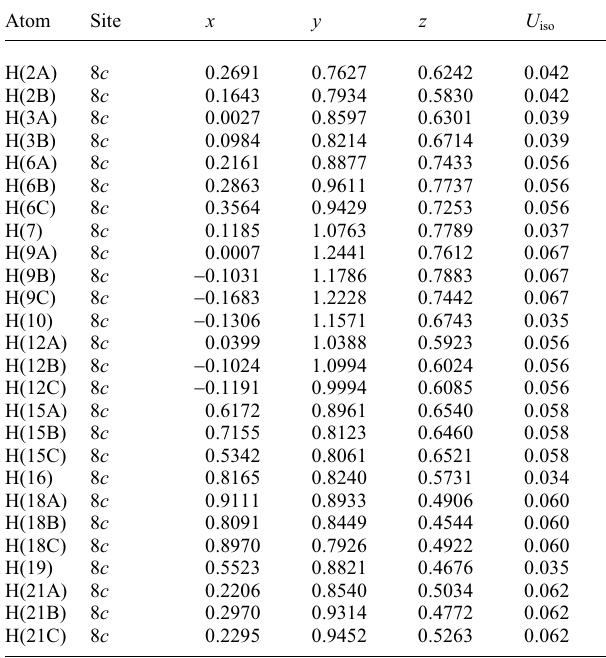
Table 2. Atomic coordinates and displacement parameters (in Å 2 )